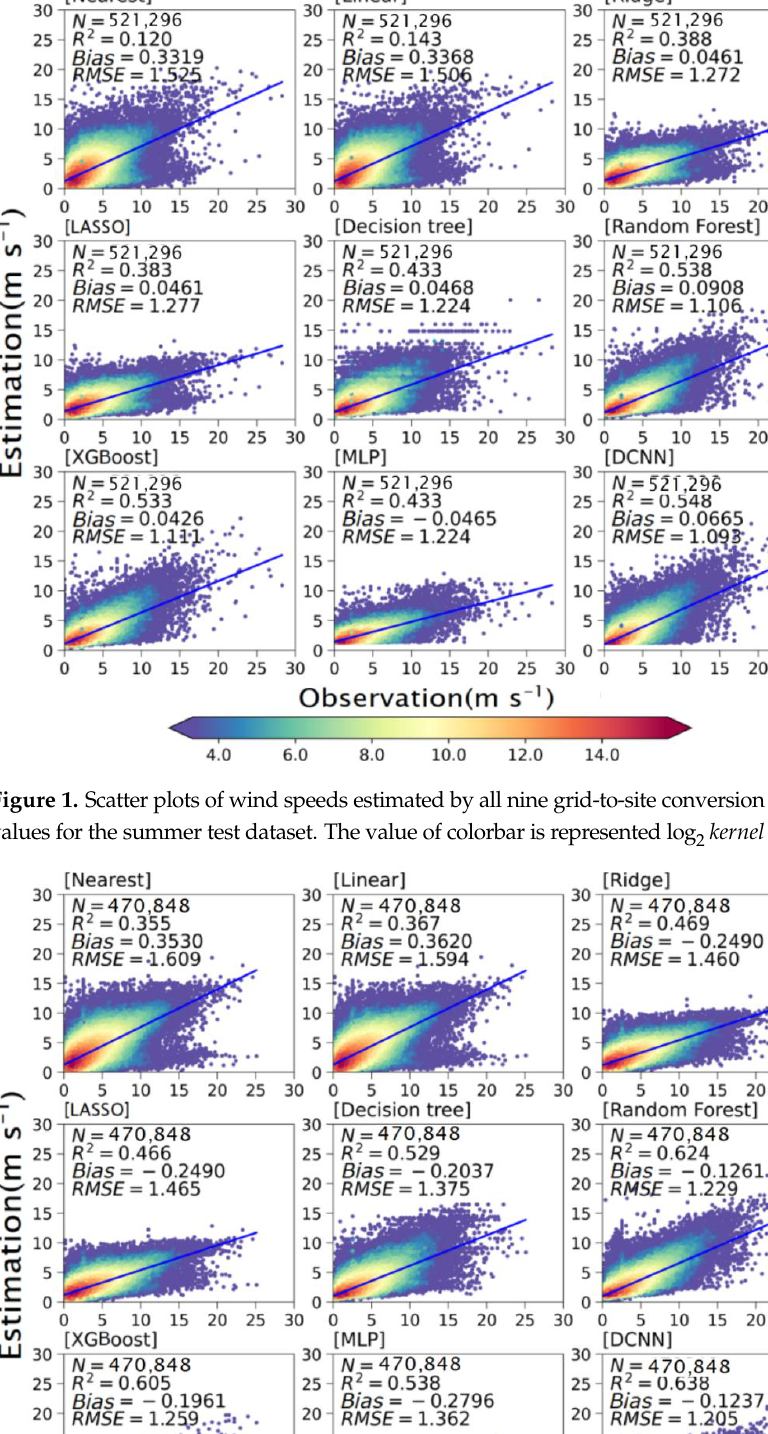
Figure 2. As Figure 1 but for the winter test dataset.